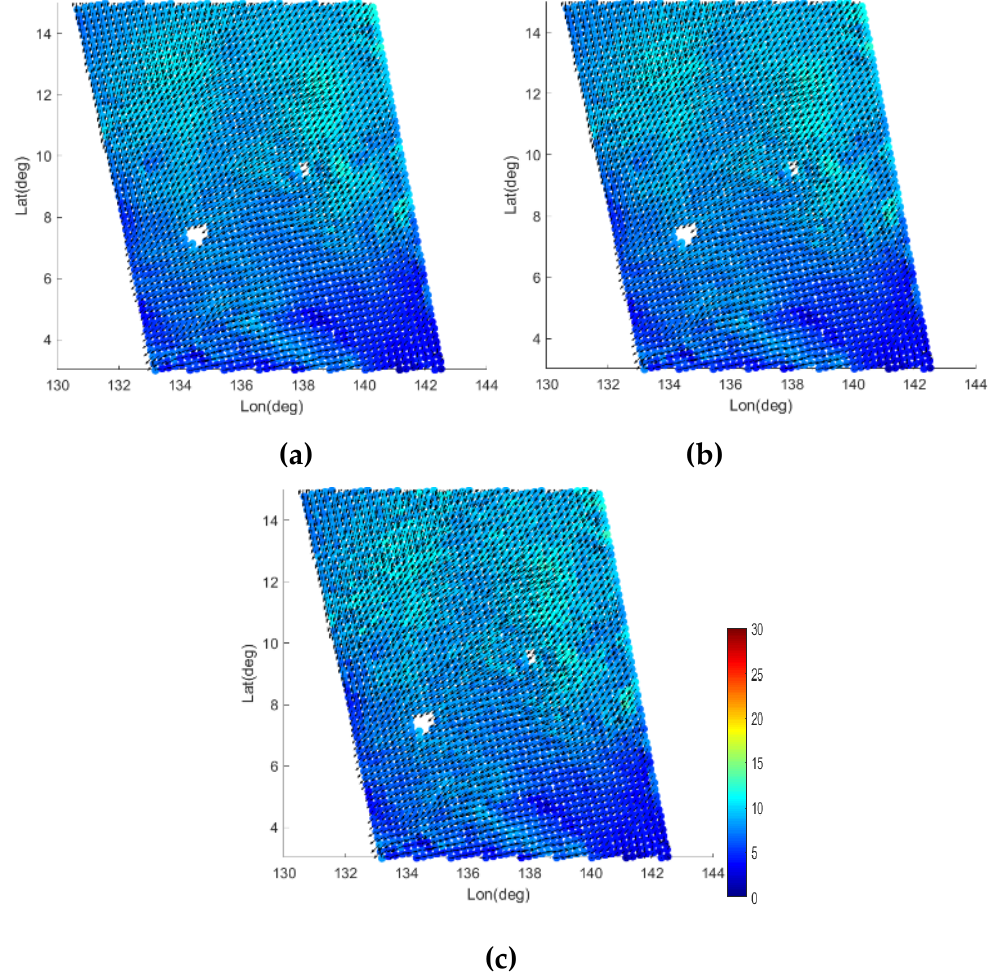
Figure 9. Wind speed of the ground L2 product ( a ) and that of the on-board procedure in a full resolution GMF LUT ( b ) and a desampled GMF LUT ( c ). Color indicates wind speed in m/s.